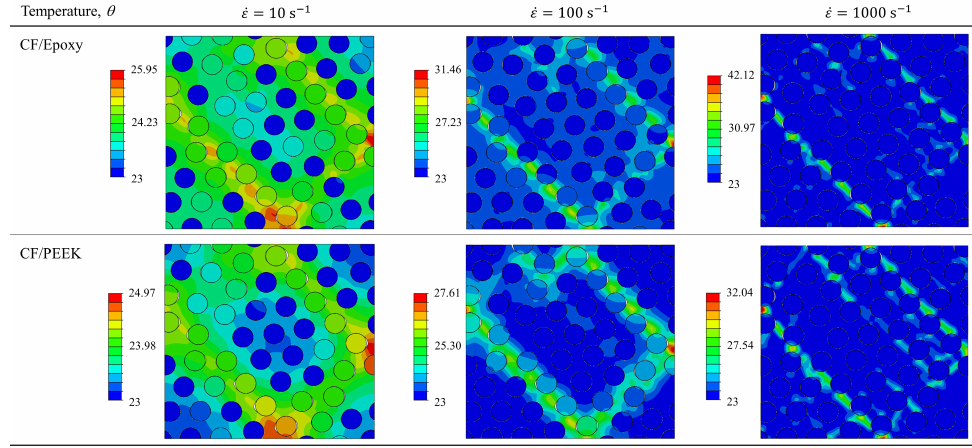
Figure 21. Temperature profiles of CF/PR520 and CF/PEEK systems at three high strain rates and a strain level of